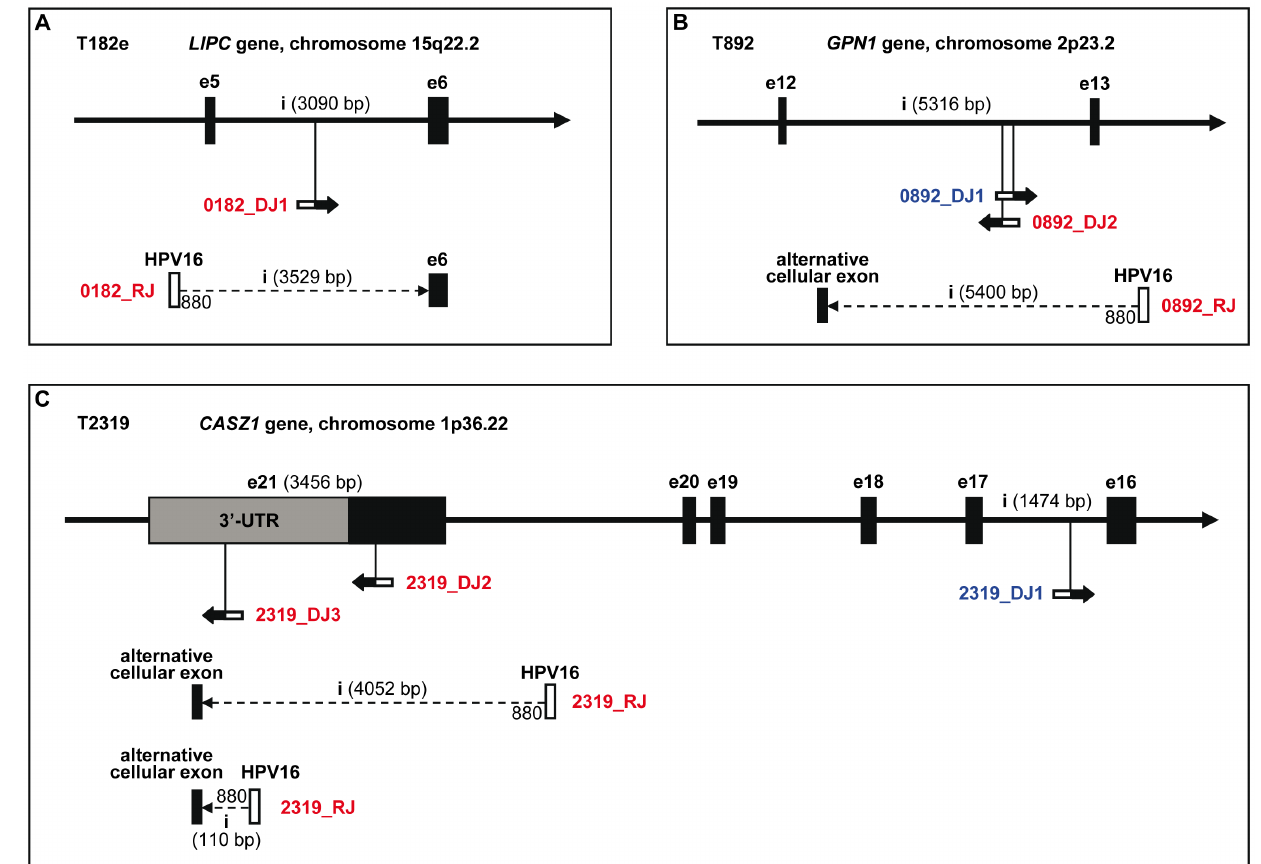
Figure 3. Examples of intragenic HPV16 DNA integration sites. (A) Tumor T182e has one HPV16 integration site 0182_DJ1, which is transcriptionally active (TA-group 1). The integrated HPV16 DNA is located in the intron (i) between exons (e) 5 and 6 of the cellular gene LIPC